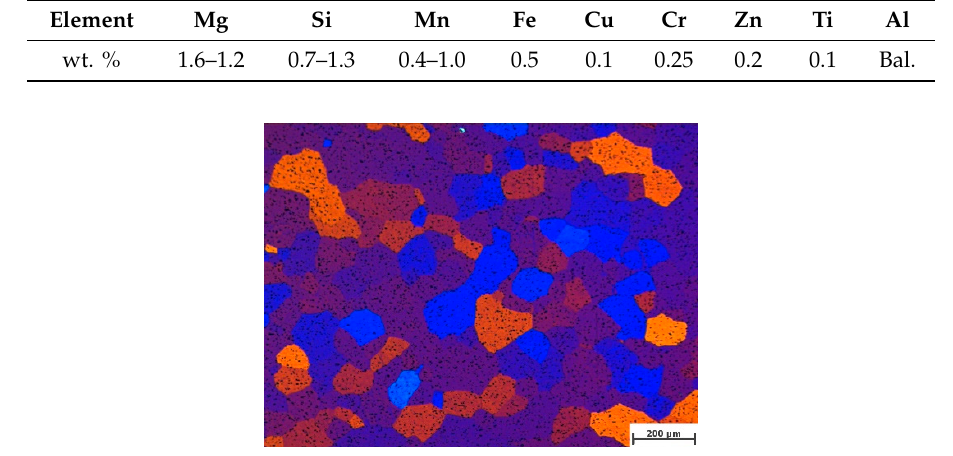
Figure 2. Metallographic structure of as received AA6082.